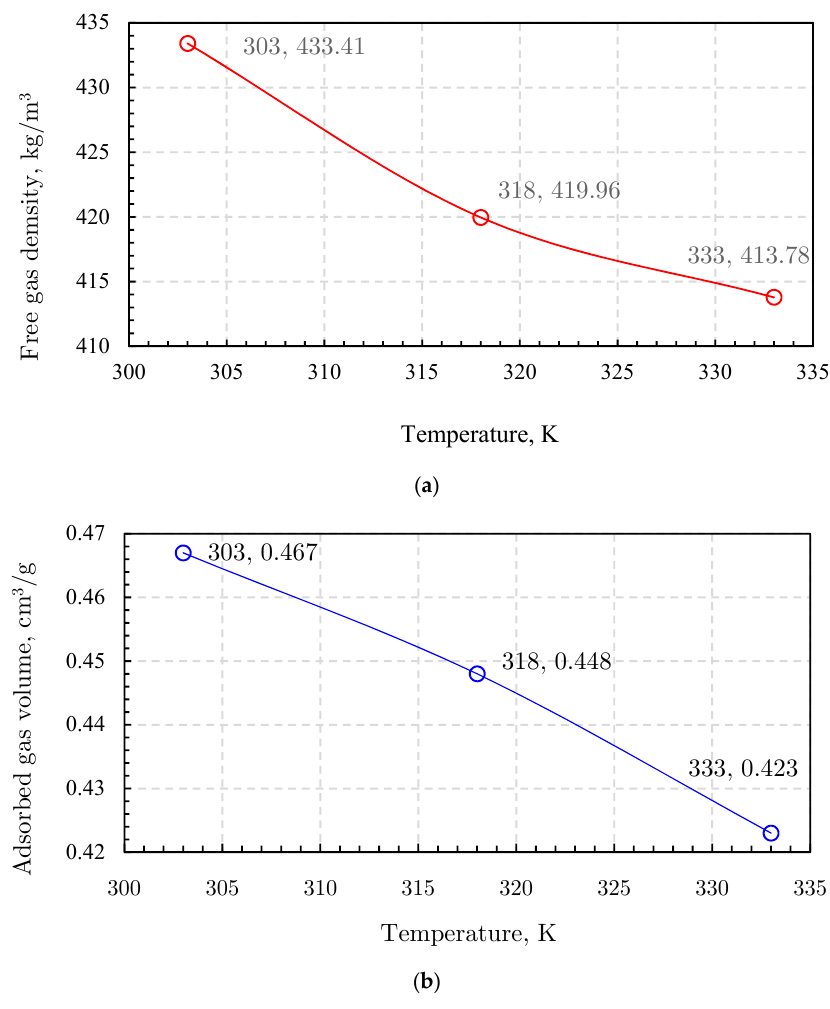
Figure 35. The change in adsorbed gas density ( a ) and adsorbed gas volume ( b ) with temperature, calculated by an experimental method.